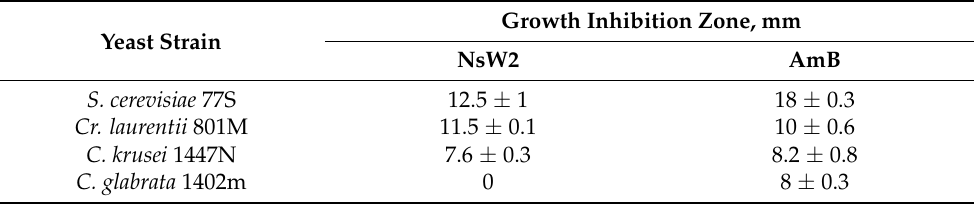
Table 4. The activity of purified NsW2 on the growth of clinical yeast strains.